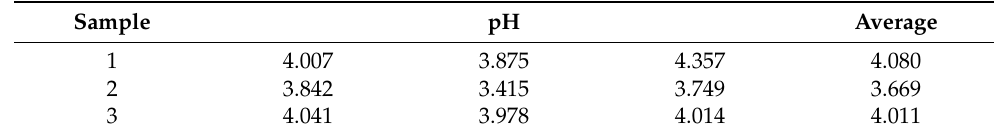
Table 1. pH values of the